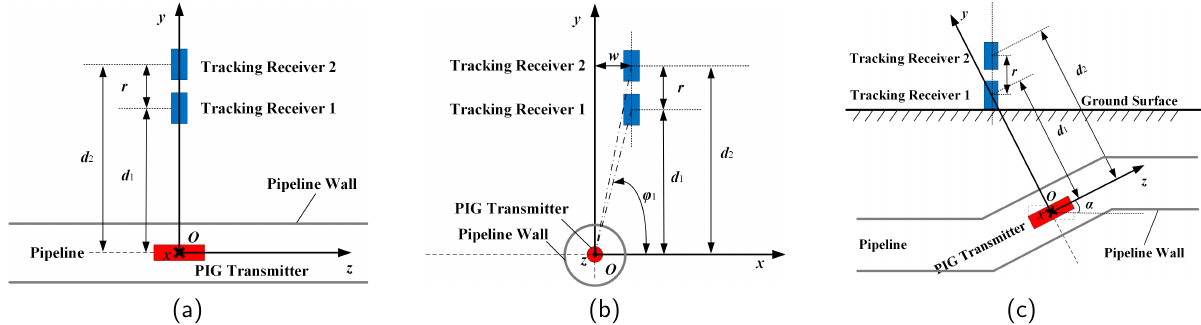
Figure 3. Possible relative position cases between the PIG transmitter and receivers: ( a ) the normal case; ( b ) the lateral offset case; ( c ) the pitch angle